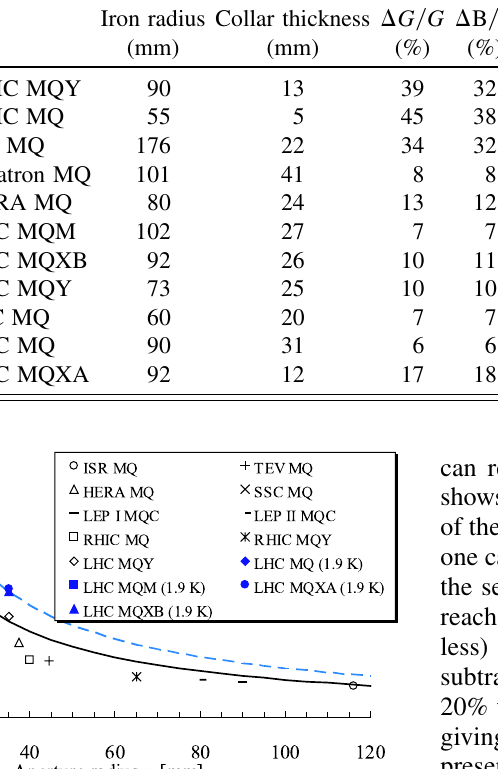
TABLE VI. Increase of parameters (cid:4) and (cid:5) , and of the critical gradient, due to the iron yoke for some superconducting magnets.